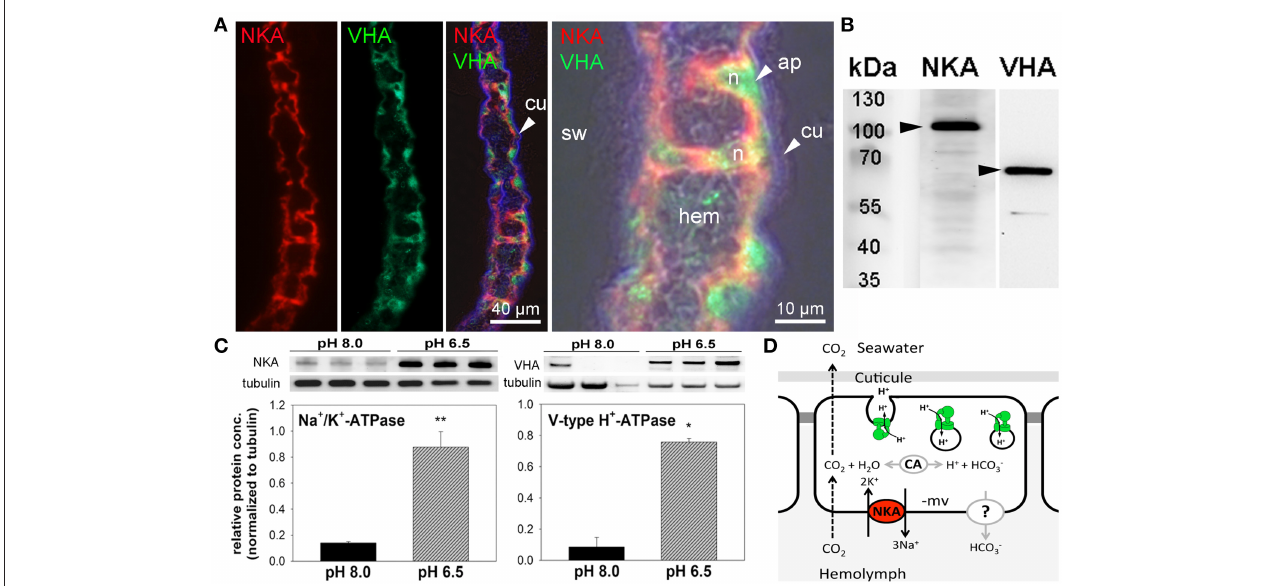
FIGURE 4 | Immuno-histochemical localization of Na + /K + -ATPase and V-type H + -ATPase in branchial epithelia. Positive Na + /K + -ATPase (NKA) (red) immunoreactivity in basolateral membranes of the 5th gill pair of a control (pH 8) animal (A) . Positive immunoreactivity of the V-type H + -ATPase (VHA) (green) antibody is mainly located in the cytoplasm of single epithelial as well as pillar cells. Background fluorescence (blue), showing the lining of the cuticule along the gill lamellae. Larger magnification of one branchial lamella demonstrating the sub cellular localization of the NKA and VHA including a bright field overlay to visualize the histology of this tissue (A) . Western blot analyses using gill homogenates, indicating specific immunoreactivity of the different antibodies with proteins in the predicted size range (B) . Determination of NKA and VHA protein concentrations normalized to tubulin in posterior gills after 12h exposure to pH 8.0 and 6.5 conditions ( * p < 0.05 ; ** p < 0.01 ) (C) . Hypothetical model of acid-base regulation in epithelial cells of posterior gills in X. testudinatus (D) . NKA located in basolateral membranes energizes the import of bicarbonate via a putative basolateral HCO − 3 transporter. CO 2 diffuses across membranes along concentration gradients. Intracellular